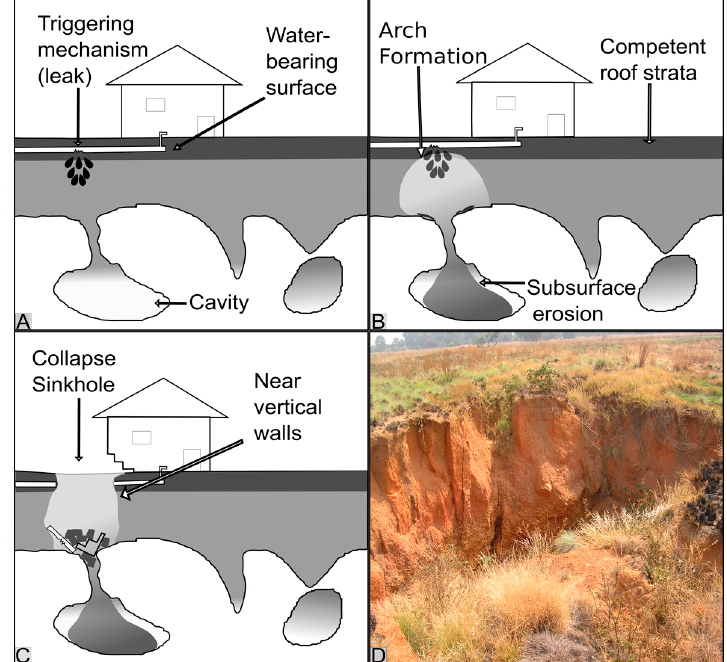
Figure 2. A graphic representation of the mechanisms of sinkhole formation. ( A ) The presence of a sub-surface cavity and a triggering mechanism initiates the process of subsurface erosion; ( B ) Competent roof strata supports the formation of an arch; ( C ) Sudden collapse can lead to damage to infrastructure and pose a health and safety risk; ( D ) An example of a cover collapse sinkhole in South Africa.